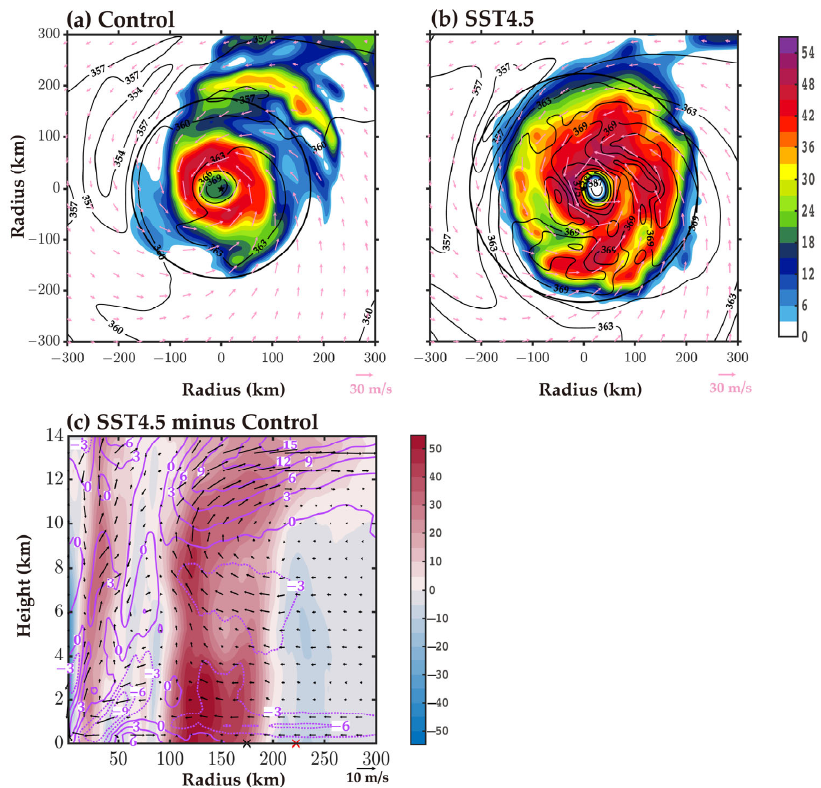
Figure 5. ( a ) The column maximum reflectivity (shaded; dBZ) and equivalent potential temperature at the model’s lowest level (black contours; 3 K interval) in the control at 11/06. Horizontal flow vectors are superimposed. For clear visualization, reflectivity and equivalent potential temperature are smoothed. The horizontal and vertical axes indicate the distance (km) from the storm center (black pentagram). ( b ) As in ( a ) but for SST4.5. ( c ) The difference of azimuthally averaged reflectivity (shaded; dBZ) and radial velocity (purple contours; 3 m s − 1 interval; negative values are dotted for inflow, and positive values are solid for outflow) between SST4.5 minus the control at 11/06. The dif- ferences of the in-plane flow vectors (vertical velocity component multiplied by 5) are superimposed. The black and red crosses indicate the cyclone R17 in the control and SST4.5 at 11/06, respectively. The horizontal and vertical axes indicate the distance (km) from the storm center and height (km), respectively. In ( c ), the horizontal and vertical axis indicate the distance (km) from the storm center and height (km), respectively. The D3 output at 0600 UTC 11 October is utilized for ( a – c